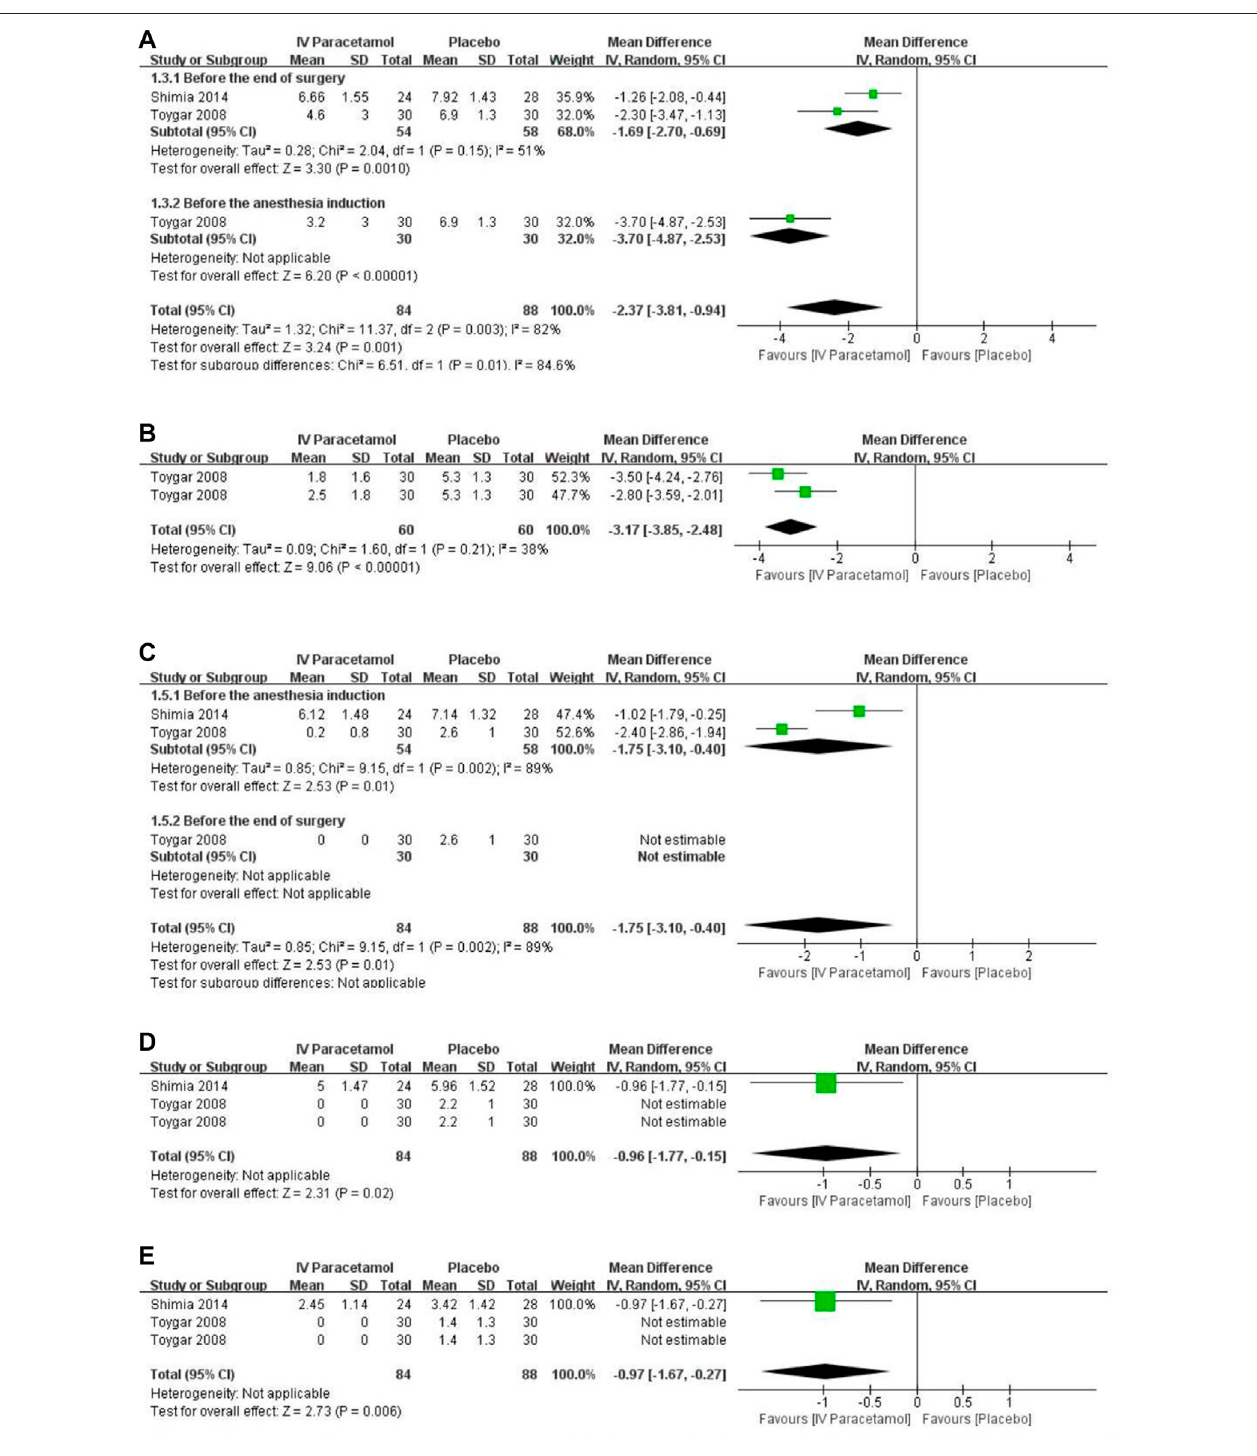
FIGURE 4 | Forest plot for pain scores at (A) 1 h, (B) 2 h, (C) 6 h, (D) 12 h, and (E) 24 h. IV, intravenous. SD, standard deviation. CI, con fi dence interval.